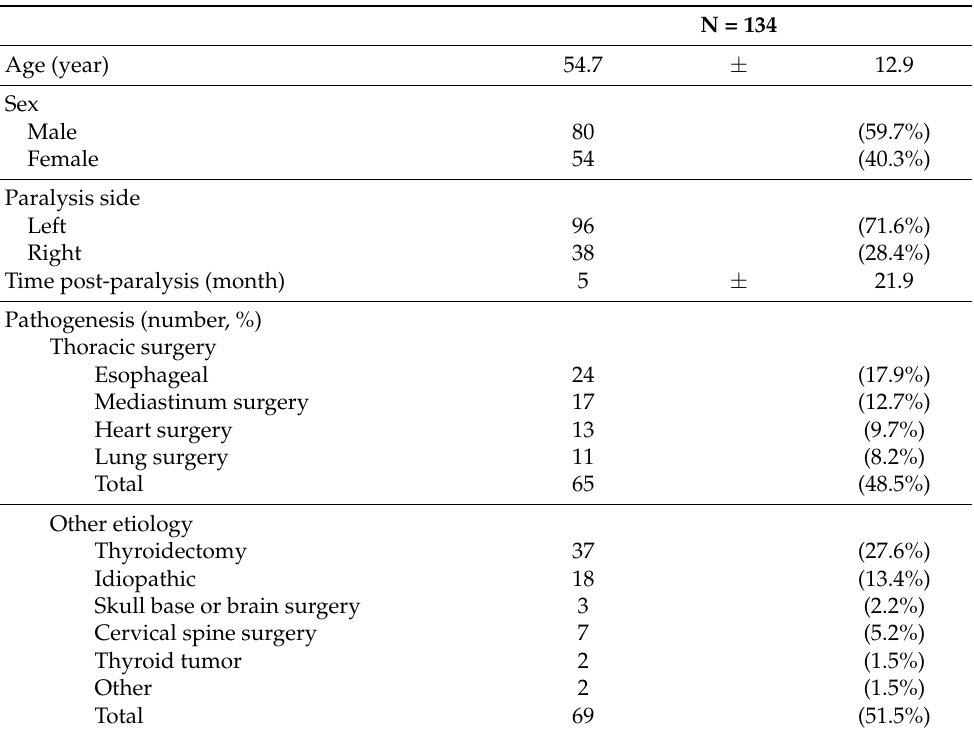
Figure 4. Experimental flowchart. A total of 194 patients with UVFP were recruited, among whom 5 were excluded due to no TA-LCA involvement, 18 due to incomplete LEMG data, and 37 due to the coexistence of CT muscle involvement. Table 1. The demographics of the UVFP patients without cricothyroid involvement .